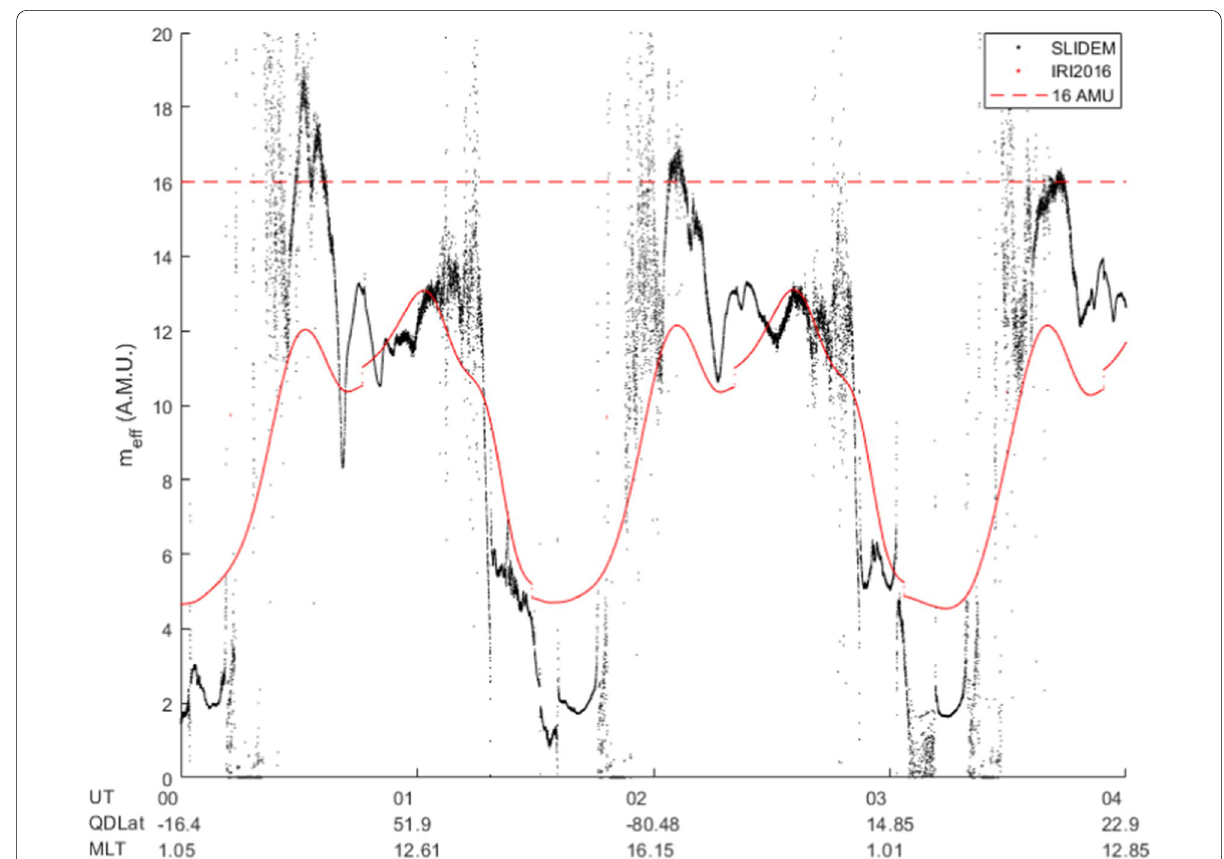
Fig. 4 Swarm A effective ion mass estimation using SLIDEM and IRI-2016 for a representative time period (1 May 2018). Data is shown for the entire orbit period, including times when significant along-track ion drifts are